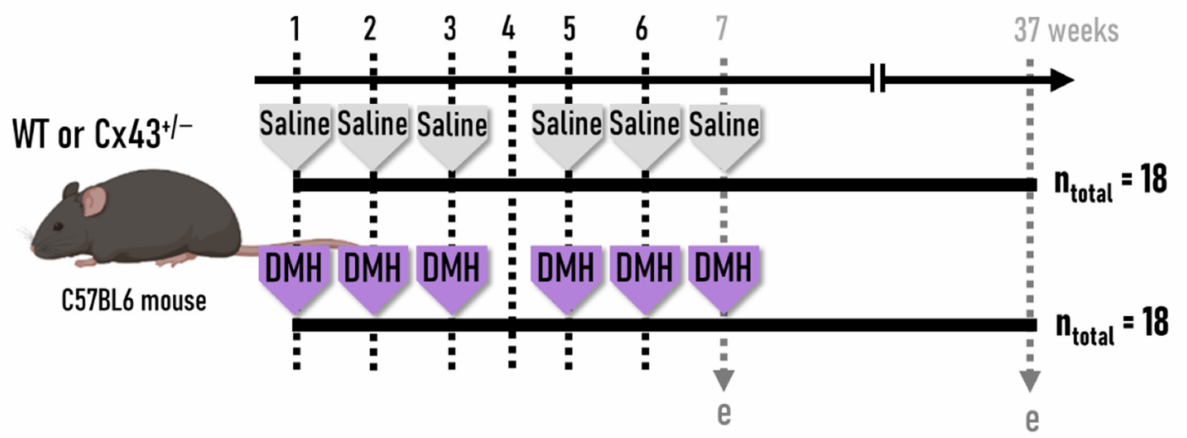
Figure 1. Experimental design. Saline: 1 × NaCl 0.9% i.p. administration; DMH: 1 × 20